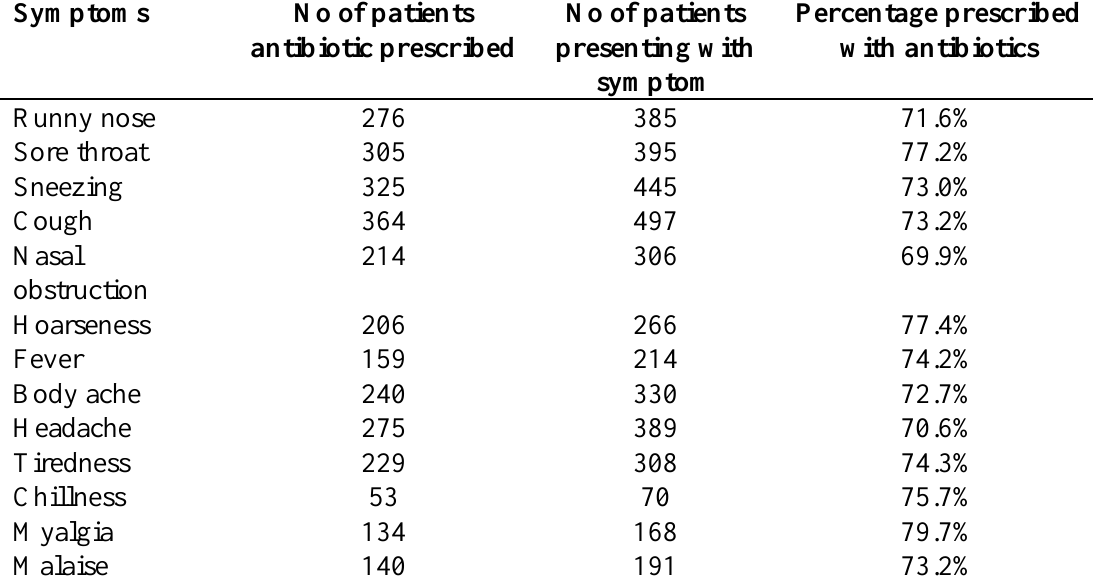
Table 3 Prescription of antibiotics for patients with different